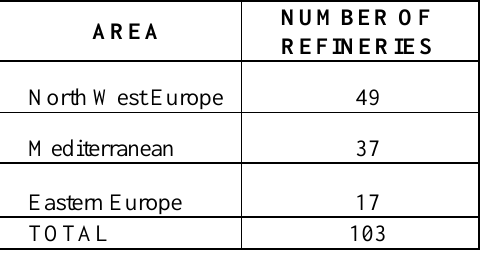
Figure 4: European Refineries by Area –